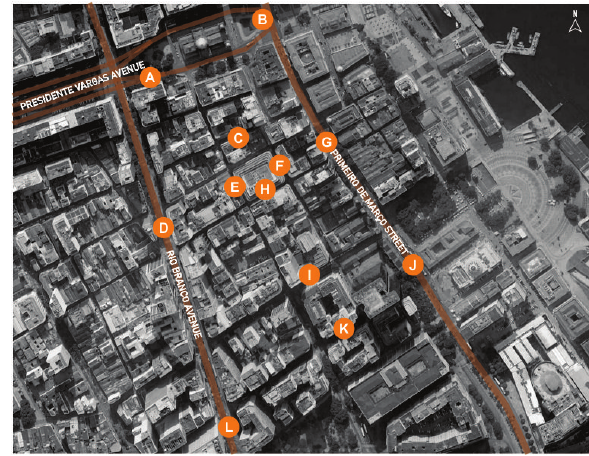
Figure 1: Map of Rio de Janeiro city center and study area high- lighted in red